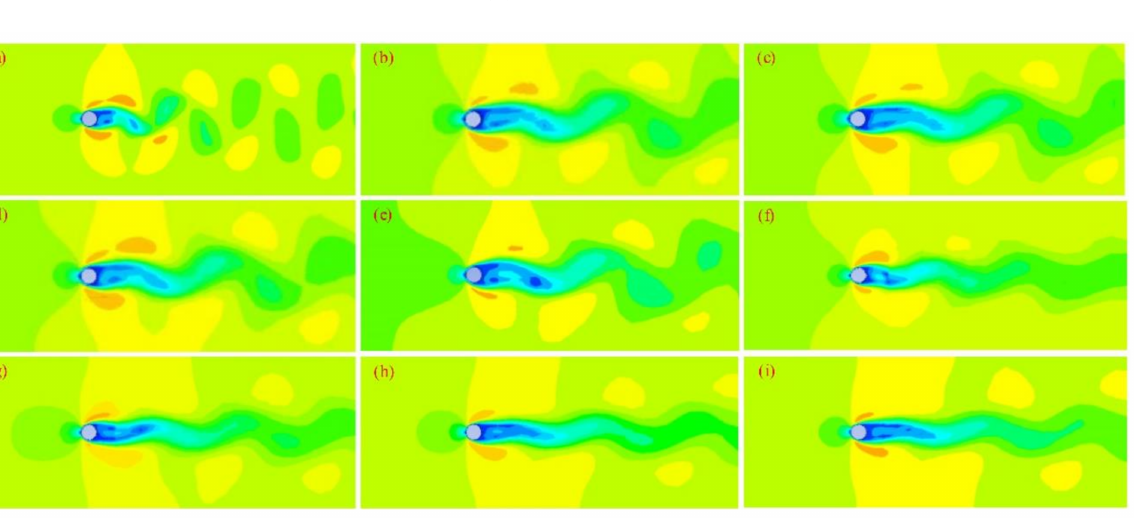
Figure 9. Vorticity simulation of the TS–tower: ( a ) O–tower; ( b ) θ = 45 ◦ ; ( c ) θ = 50 ◦ ; ( d ) θ = 55 ◦ ; ( e ) θ = 61 ◦ ; ( f ) θ = 65 ◦ ; ( g ) θ = 70 ◦ ; ( h ) θ = 75 ◦ ; and ( i ) θ = 80 ◦